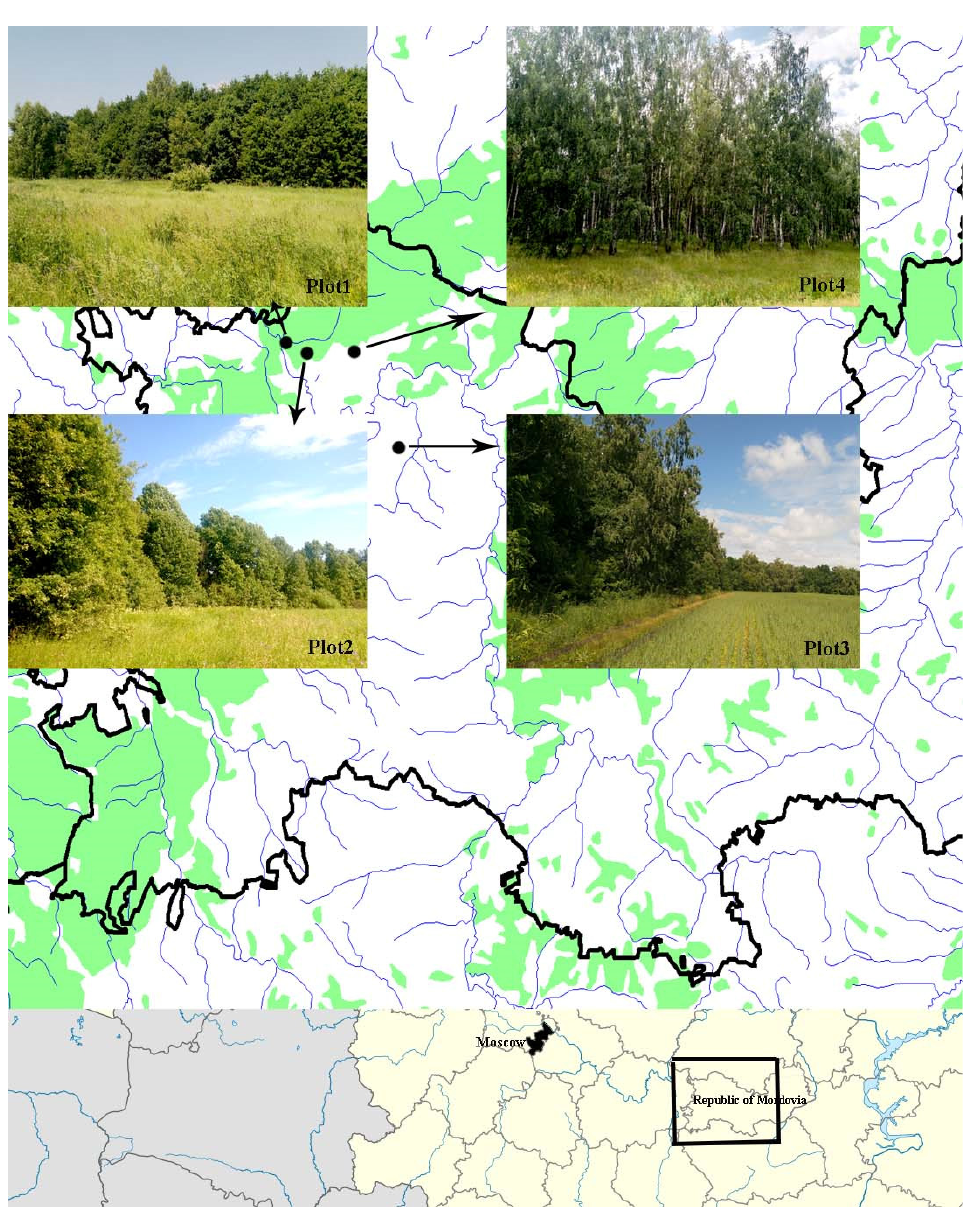
Figure 1. Research plots and photos of biotopes. The black box represents the study area. Four plots were studied. Each plot represented an open ecosystem (floodplain meadow, large meadow, meadow, and agroecosystem) and a deciduous forest located nearby. The forest adjoined closely to this open ecosystem. On the border (i.e., ecotone) of the open space and the forest area, a forest edge was formed. In addition, in the forest interior, at 300–350 m, a control inner plot of the forest with a closed canopy was selected. All experiments were performed simultaneously in two repetitions. Thus, there were 8